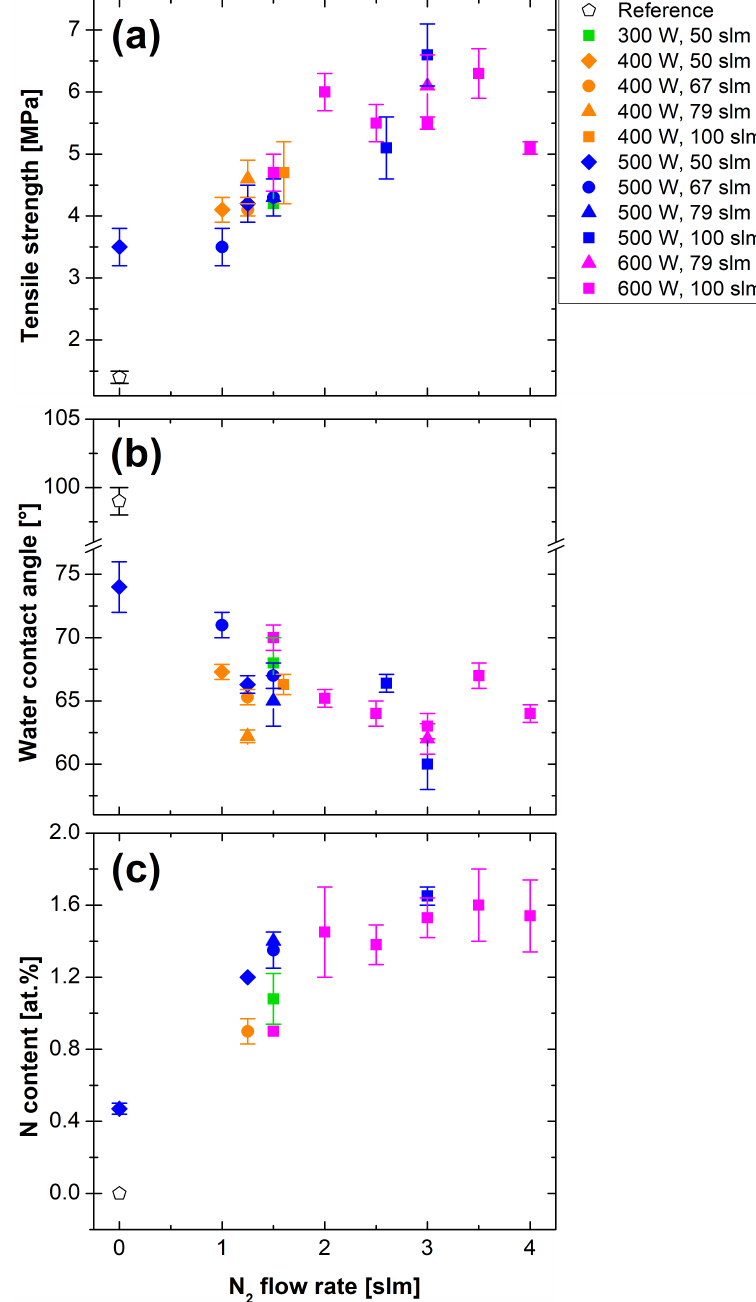
Figure 5. Dependence of the ( a ) tensile strength, ( b ) water contact, angle and ( c ) nitrogen content of the plasma-treated PP on the nitrogen working gas flow